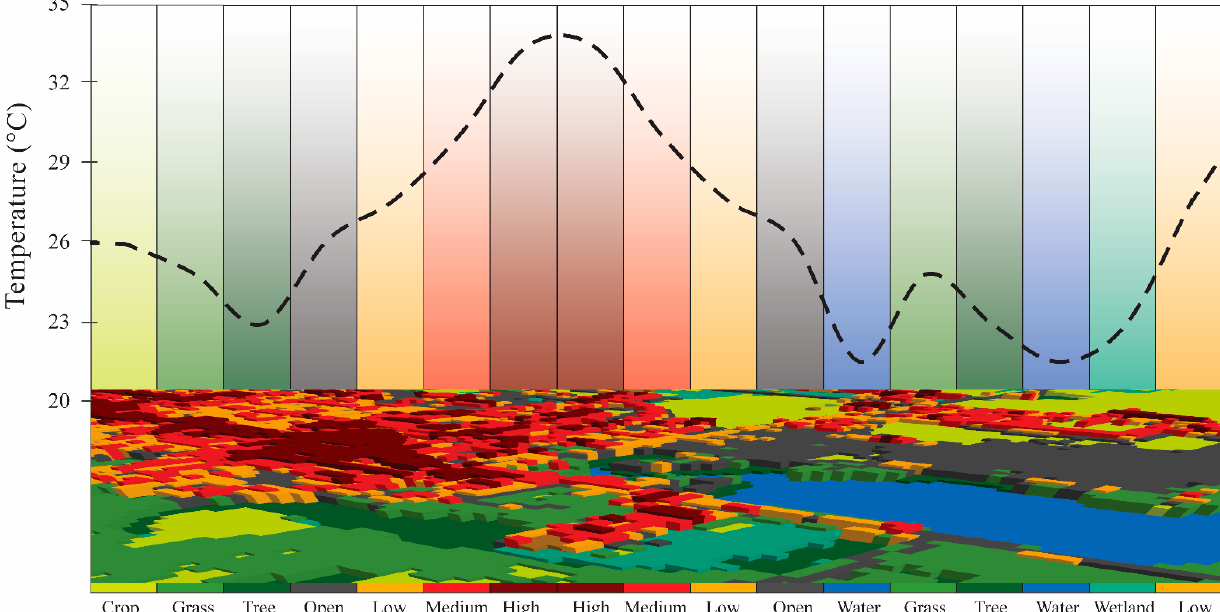
Figure 1. An example of UHI and UHIRIP in the urban and the urban and non-urban interface for part of the Sioux Falls, SD area.